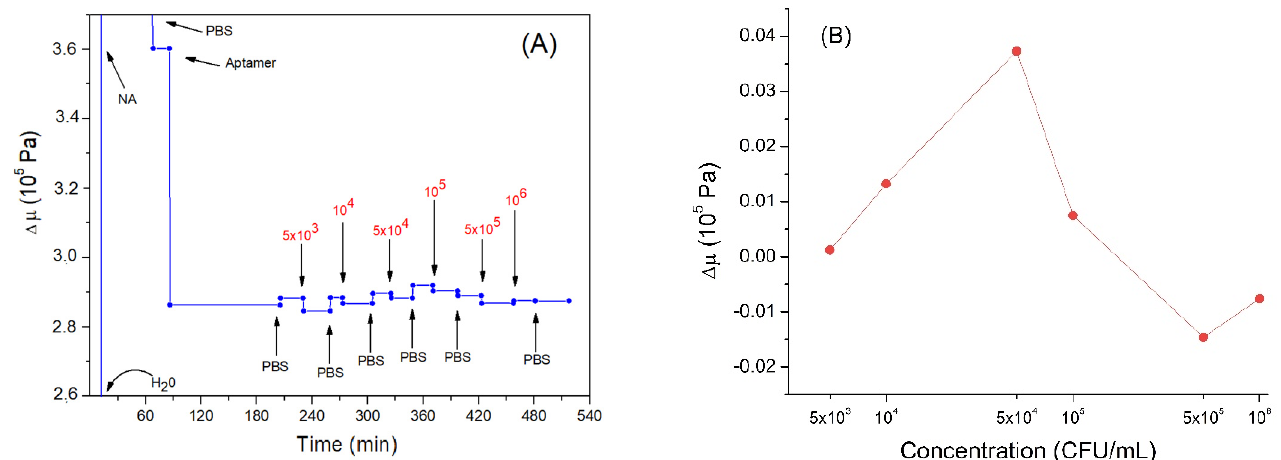
Figure 7. ( A ) the kinetics of the elastic coefficient during formation of the aptamer layer and following addition of Listeria innocua (in CFU/mL). The first three values are not shown in the graph, to better highlight the subsequent variations. ( B ) changes in elastic coefficient depending on applied bacteria concentration in logarithmic scale. Addition of various compounds and washing the surface by water or PBS is shown by arrows.